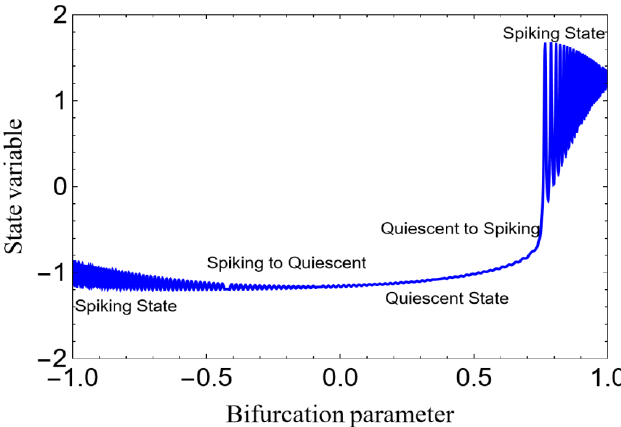
Figure 1. Two important bifurcation behaviors: the bifurcation from the quiescent state to the spiking state and the bifurcation from the spiking state back to the quiescent state. Izhikevich improved Rinzel ’ s classification method based on the geometric shape of the bursting and proposed a classification method based on the switching bifurcation mode between the quiescent state and the spiking state. According to the difference in bifurcation modes switching between quiescent state and spiking state, Izhikevich classi- fied all possible bursting oscillations in which only codimension one bifurcation occurred in the fast subsystem [13,14], and pointed out six types of codimension one bifurcation in the plane: fold bifurcation, saddle node bifurcation on the invariant torus, supercritical Hopf bifurcation, subcritical Hopf bifurcation, fold limit cycle bifurcation and homoclinic bifurcation. Different categories of bursting oscillations and their inducing mechanism are given. It is confirmed that the same category of bursting behavior is not only the same bifurcation mechanism but also the same topology of bursting shape [15].